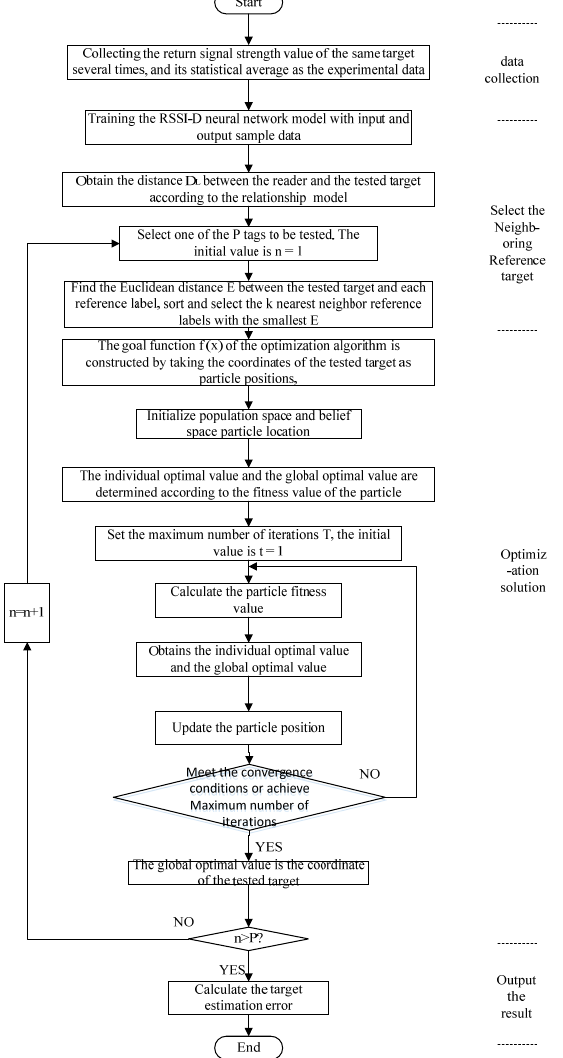
Figure 3. 3D ‐ LANDMARC coordinate solution flowchart of quantum particle swarm. Figure 3. 3D-LANDMARC coordinate solution flowchart of quantum particle